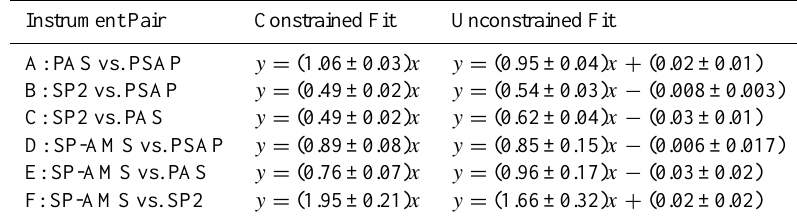
Table 1. Linear fit coefficients from instrument comparisons, where fits were performed with the first instrument listed on the y axis. The uncertainties are fit